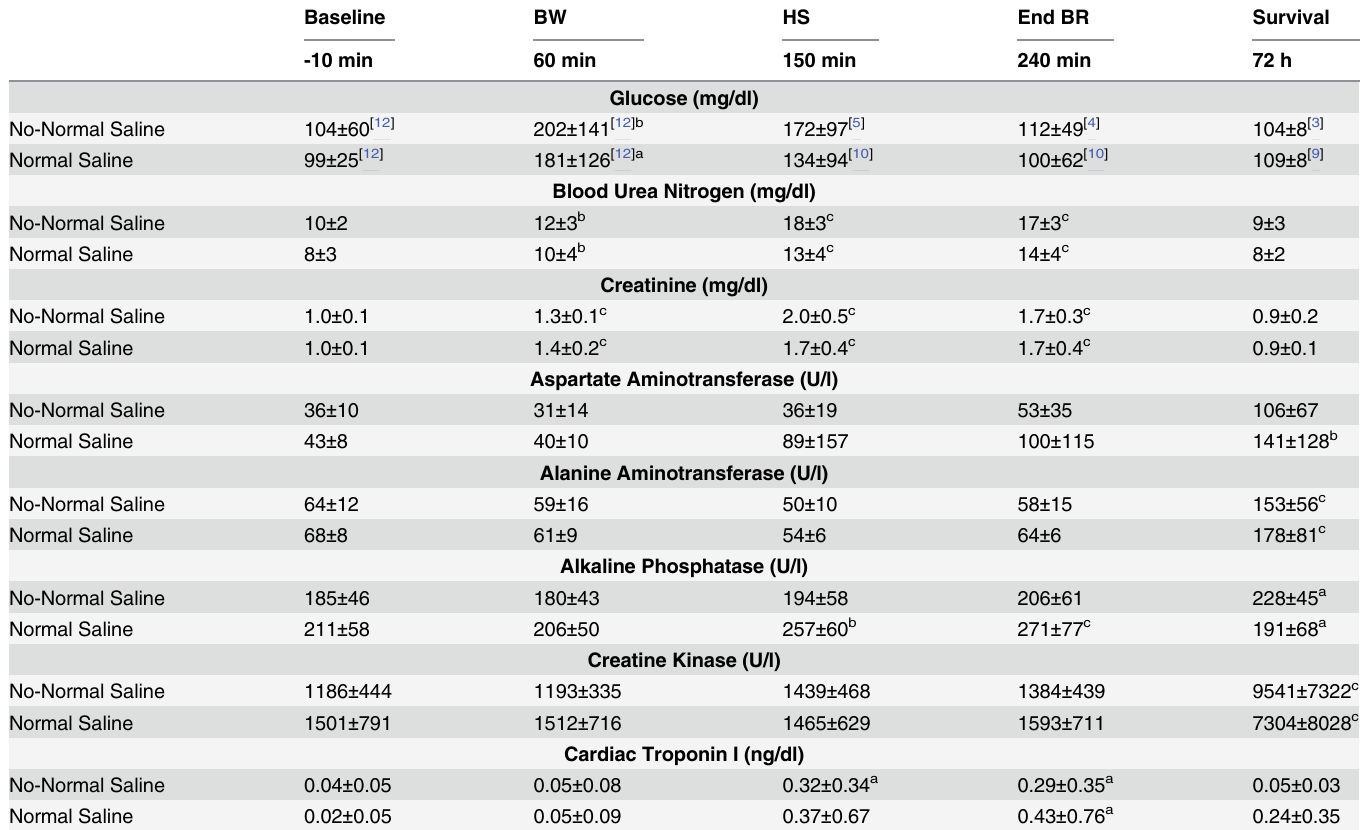
Table 2. Effect of normal saline on indices of organ function/injury. Baseline BW HS End BR Survival -10 min 60 min 150 min 240